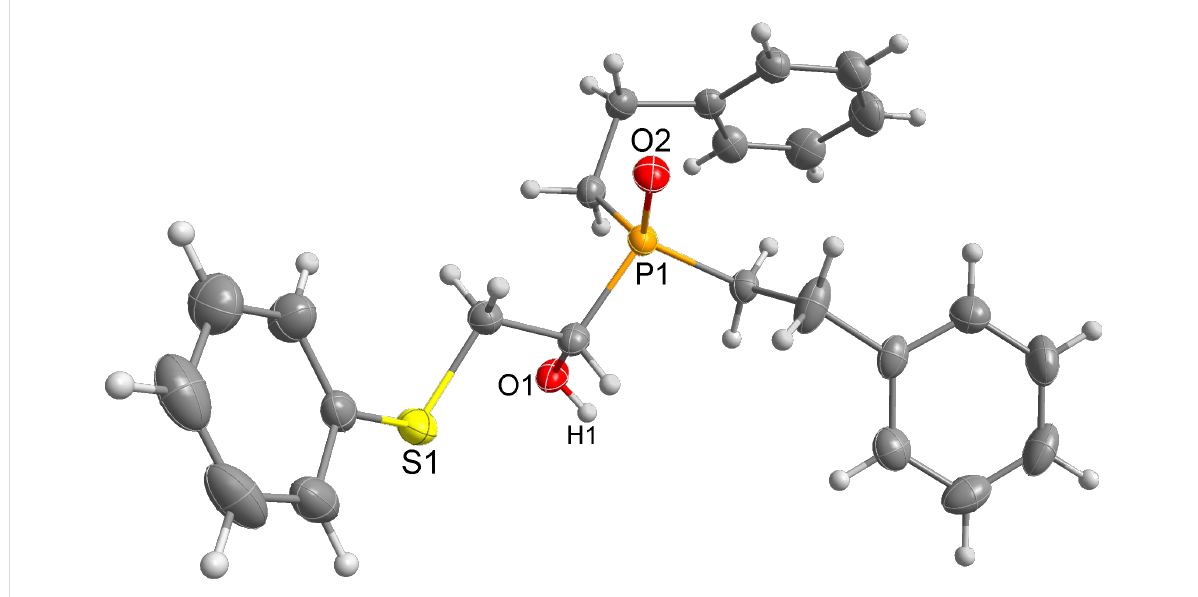
Figure 1: ORTEP drawing (30% thermal ellipsoid) of phosphine oxide 3d . A CIF file with the crystallographic data is available as Supporting Informa- tion File 2 and is also available on request from the Cambridge Crystallographic Data Centre as deposition 1046604.